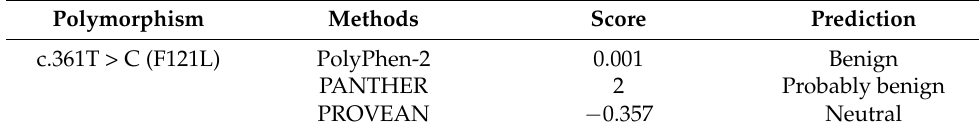
Table 7. In silico annotations of polymorphism of the bovine IFITM3 gene.